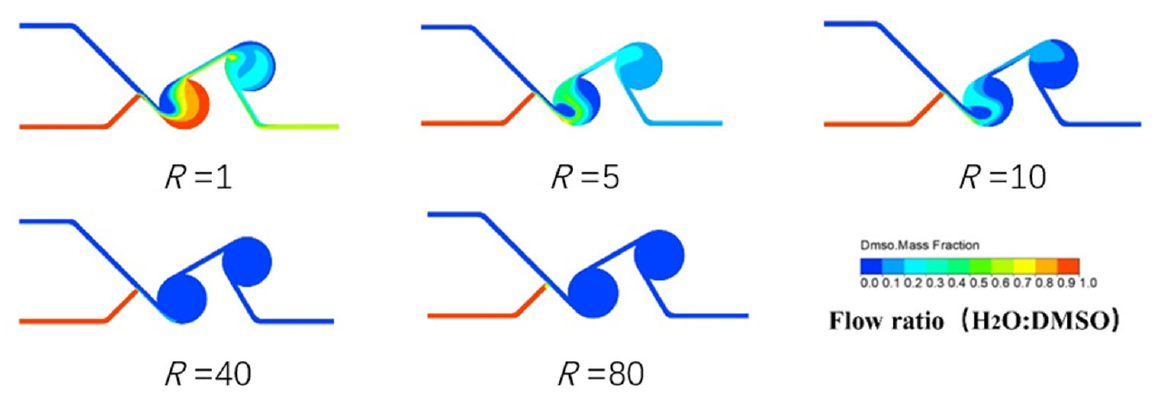
Figure 2. Simulation results with different flow ratios.